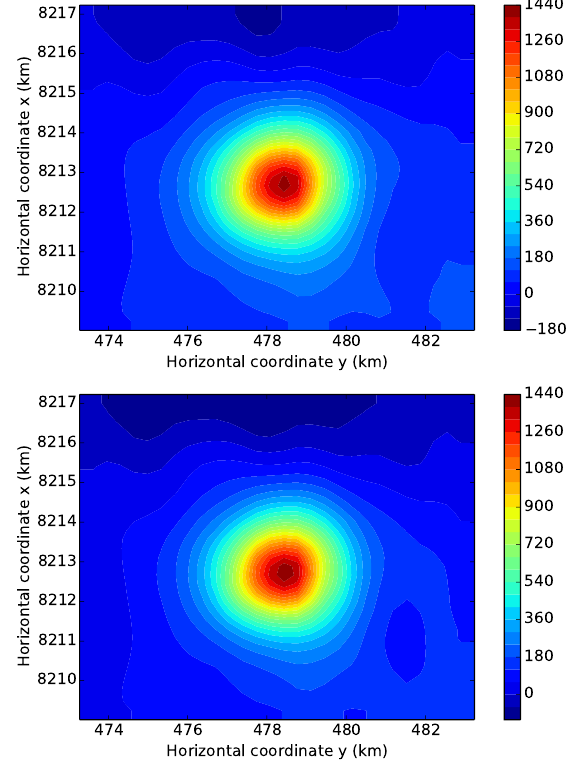
Figure 16. Application to field data on the Goiás alkaline province (GAP), Brazil. Observed total-field anomaly (Fig. 15) reduced to the pole. The upper and lower panels show the RTP anomalies computed by using, respectively, the estimated magnetization direc- tion obtained with the least-squares (inclination ˆ I = − 69 . 25595 ◦ ± 0 . 00013 ◦ and declination ˆ D = − 16 . 22821 ◦ ± 0 . 00050 ◦ ) and ro- bust (inclination e I = − 71 . 41751 ◦ ± 0 . 00182 ◦ and declination e D = − 23 . 39541 ◦ ± 0 . 01049 ◦ )